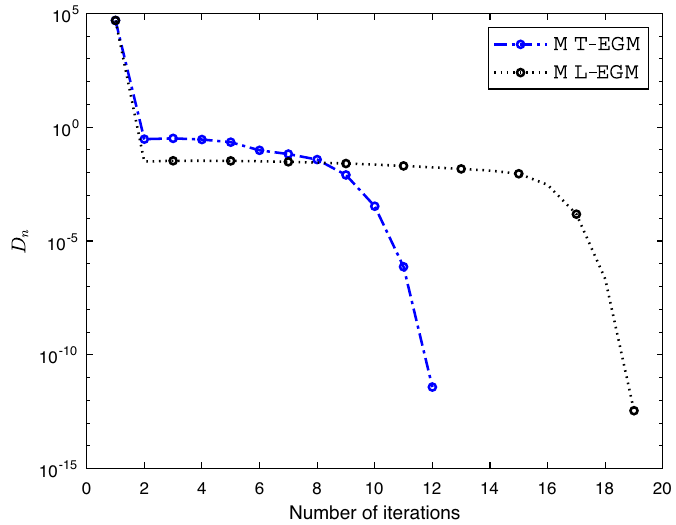
Figure 6: Numerical illustration of Algorithms 1 and 2 while u